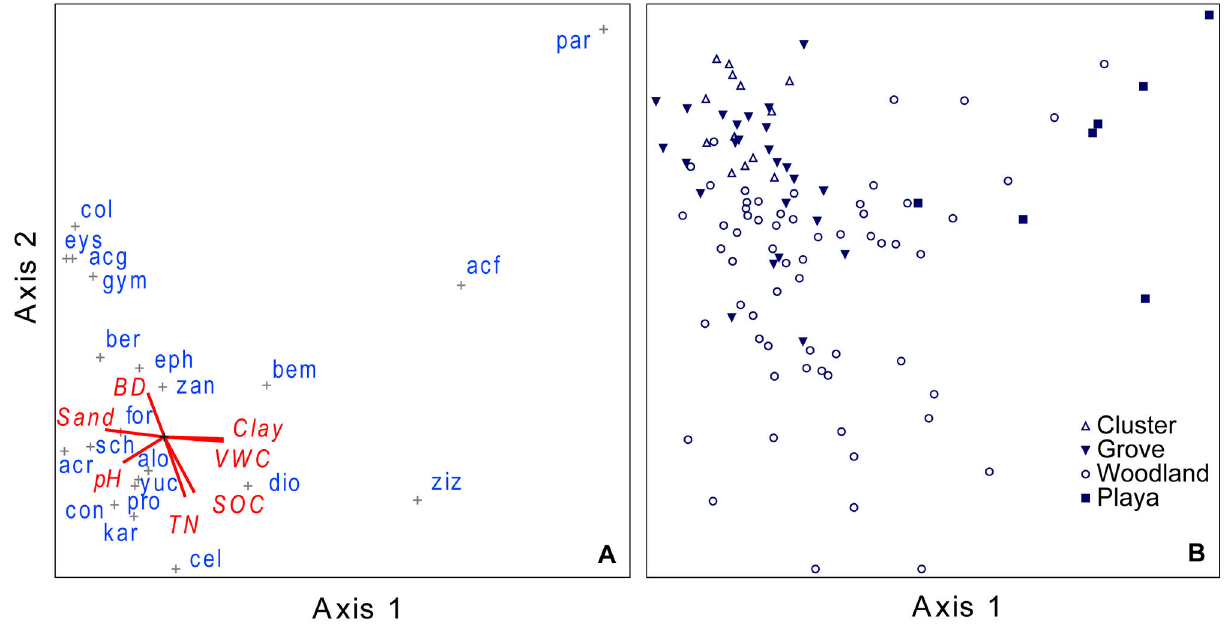
Figure 4. CCA Ordination (canonical correspondence analysis) results ordered in multivariate space along the first two canonical axes, separately depicting relationships among (A) shrub-stature species and soil variables (Table 1); and (B) 2 m × 2 m sample plots (symbols indicate community type) along a hill-slope transect. Species centroids (+) indicate center of distribution among sample plots for each shrub species coded as follows: acf = Acacia farnesiana; acg = A. greggeii ; acr = A. rigidula ; alo = Aloysia gratissima ; bem = Bernardia myricaefolia ; ber = Bernardia myricaefolia ; cel = Celtis pallida ; col = Colubrina texensis ; con = Condalia hookeri ; dio = Diospyros texana ; eph = Ephedra antisyphilitica ; eys = Eysenhardtia texana ; for = Forestiera angustifolia ; gym = Gymnosperma spp.; kar = Karwinskia humboltiana ; par = Parkinsonia aculeata ; pro = Prosopis glandulosa ; sch = Schaefferia cuneifolia ; zan = Zanthoxylum fagara ; ziz = Ziziphus obtusifolia . Lines are vectors indicating direction of increasing value (from center outward) for soil variables coded as follows: BD = bulk density; Sand and clay = soil particle percentages; SOC = soil organic carbon; TN = total